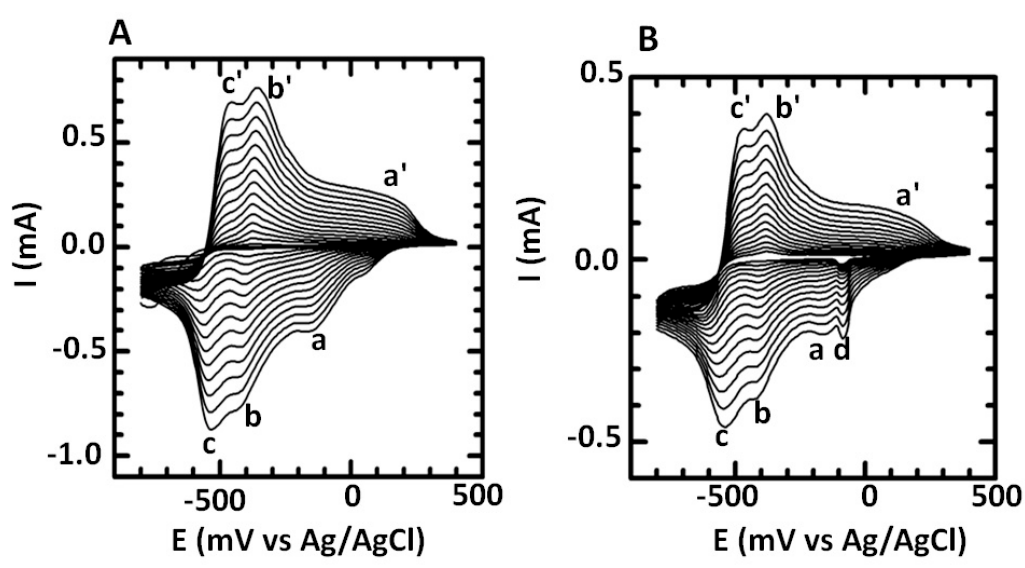
Figure 1. Cyclic voltammograms of the electropolymerization of ( A ) poly(2,5-dimethoxyaniline) (PDMA)- poly(vinylsulfonate) (PVS) and ( B ) PDMA–PVS–Ag 0 in 1 M HCl at a scan rate of 40 mV s − 1 .